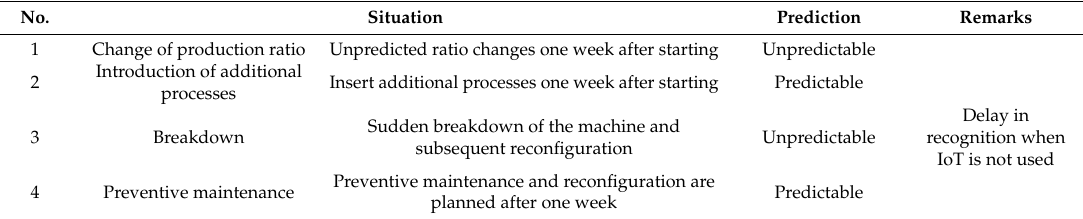
Table 6. Reconfiguration situations in simulation experiment.